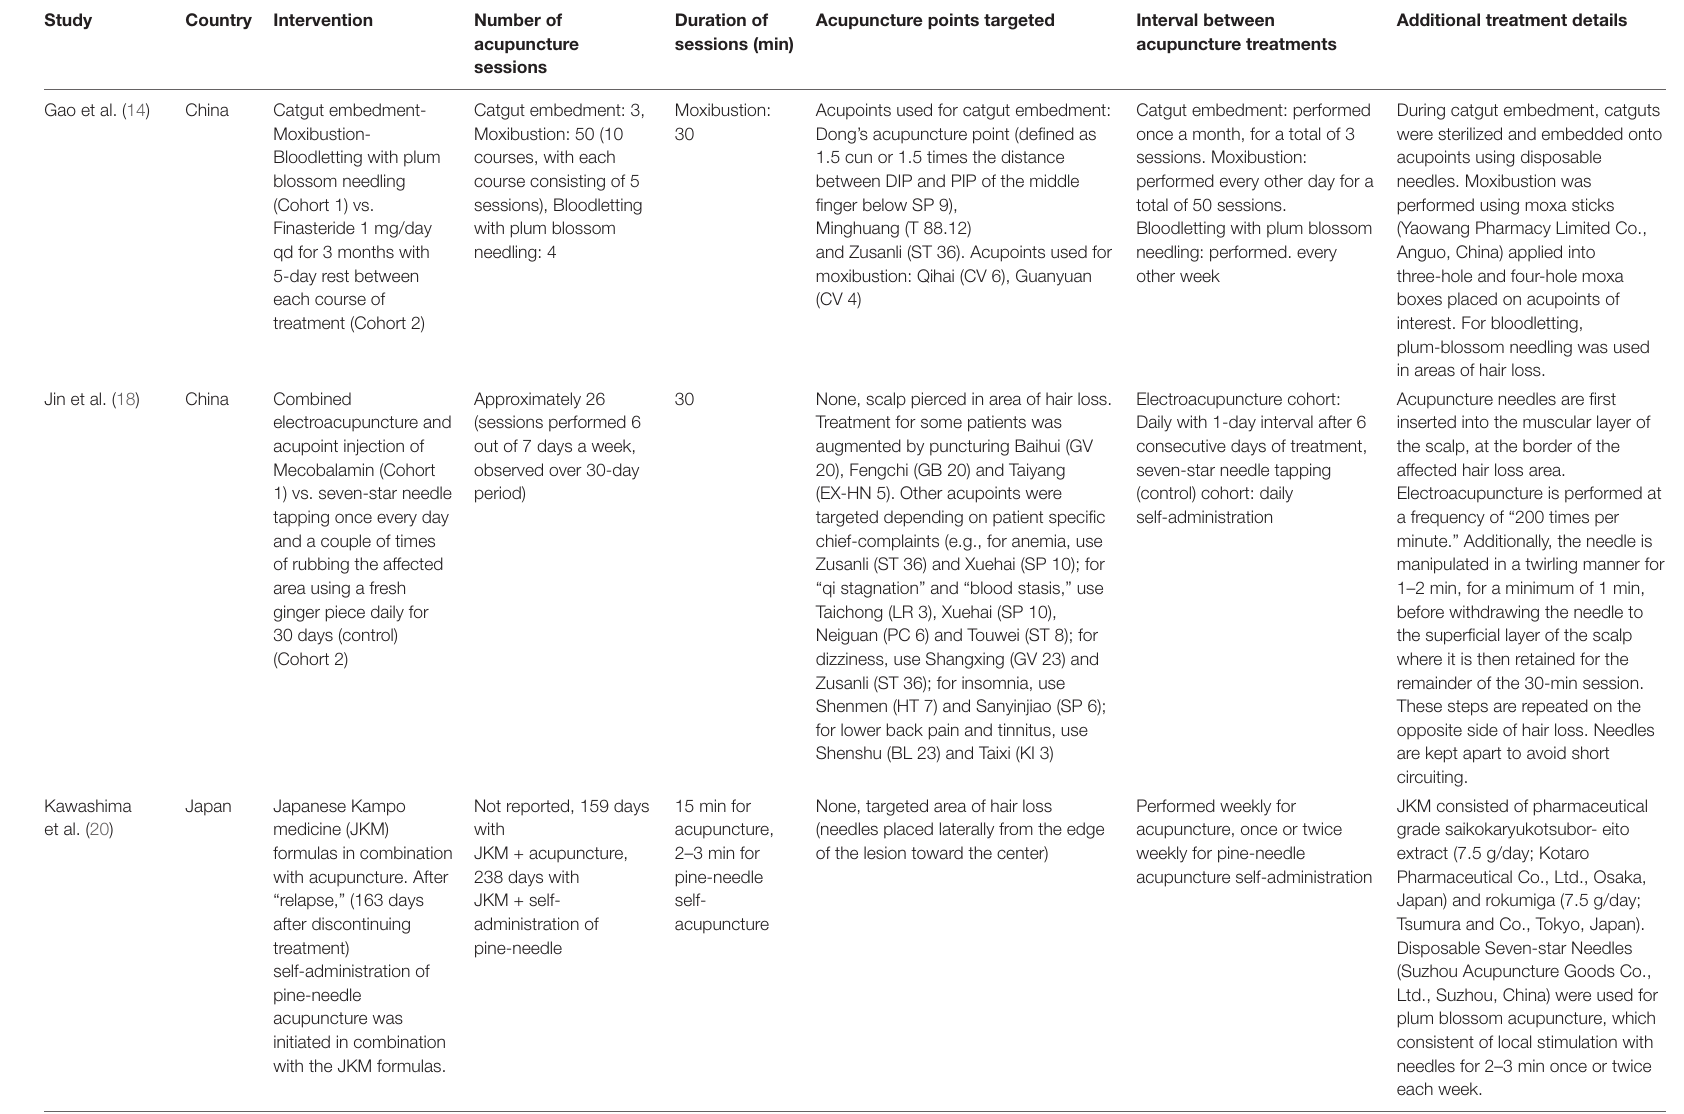
TABLE 2 | Treatment specifications and details of eligible studies.